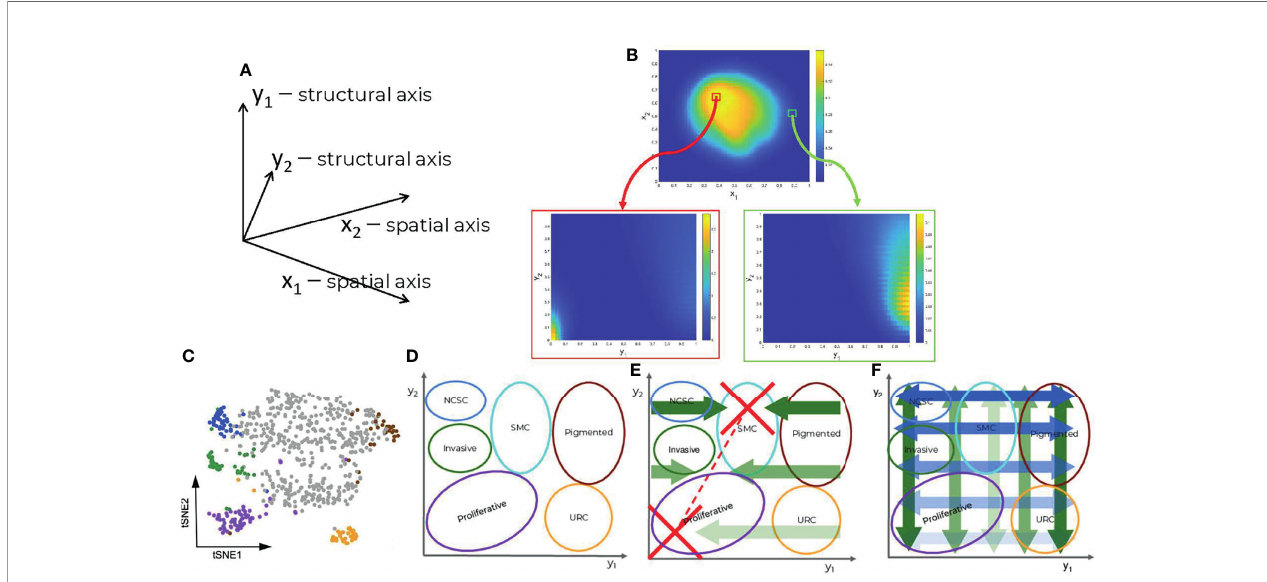
FIGURE 1 | Components of the data driven heterogeneity model: (A) Dimensions of the model. (B) Multidimensional cell distributions predicted by the model emphasizing treatment induced zoning. (C) Reduced representation of single cell expression data, from (12). (D) Cell states represented as domains in structural/ gene expression space. (E) Directed (advective) structural fl uxes. (F) Undirected (diffusive) structural fl